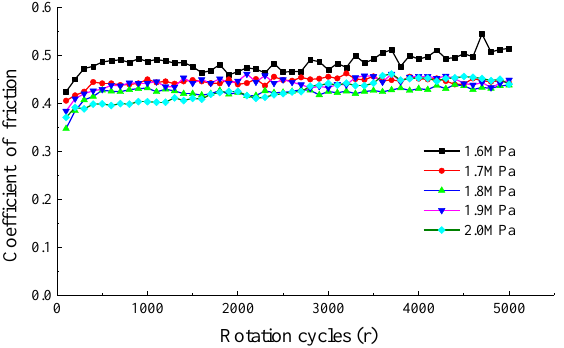
Figure 2. Evolutions of coefficients of friction between friction disc and brake shoe at different contact pressures.